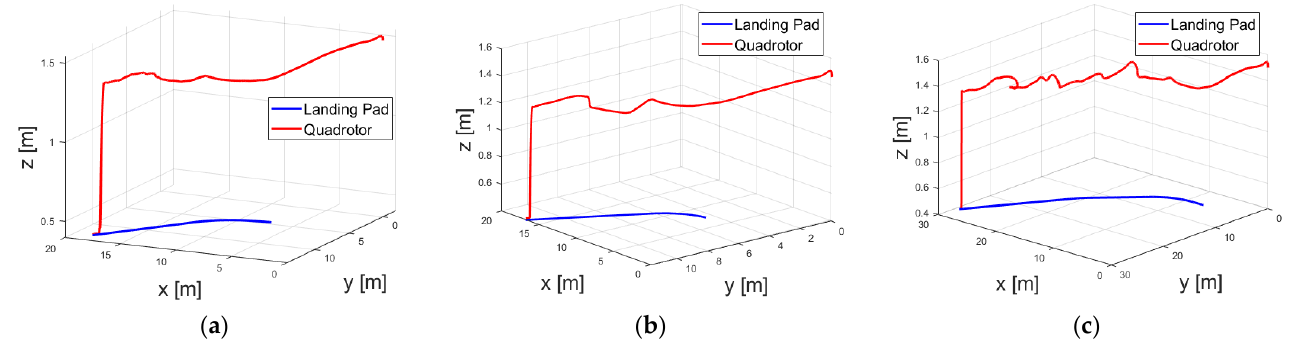
Figure 7. Trajectory of quadrotor and landing pad in case 1. ( a ) Trajectory with Gaussian noise with a standard deviation σ = 0.01. ( b ) Trajectory with Gaussian noise with a standard deviation σ = 0.5. ( c ) Trajectory with Gaussian noise with a standard deviation of σ = 1.0.